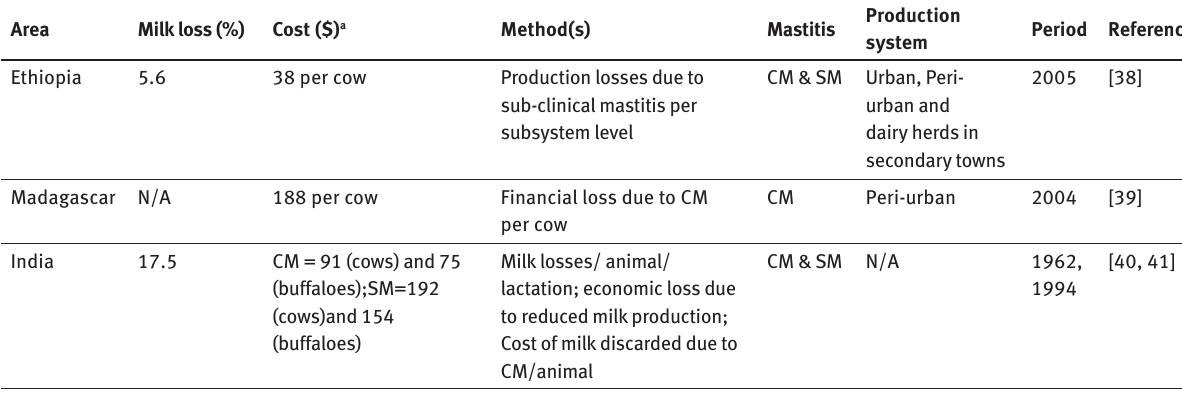
Table 1 Estimated costs due to bovine mastitis in some developing countries